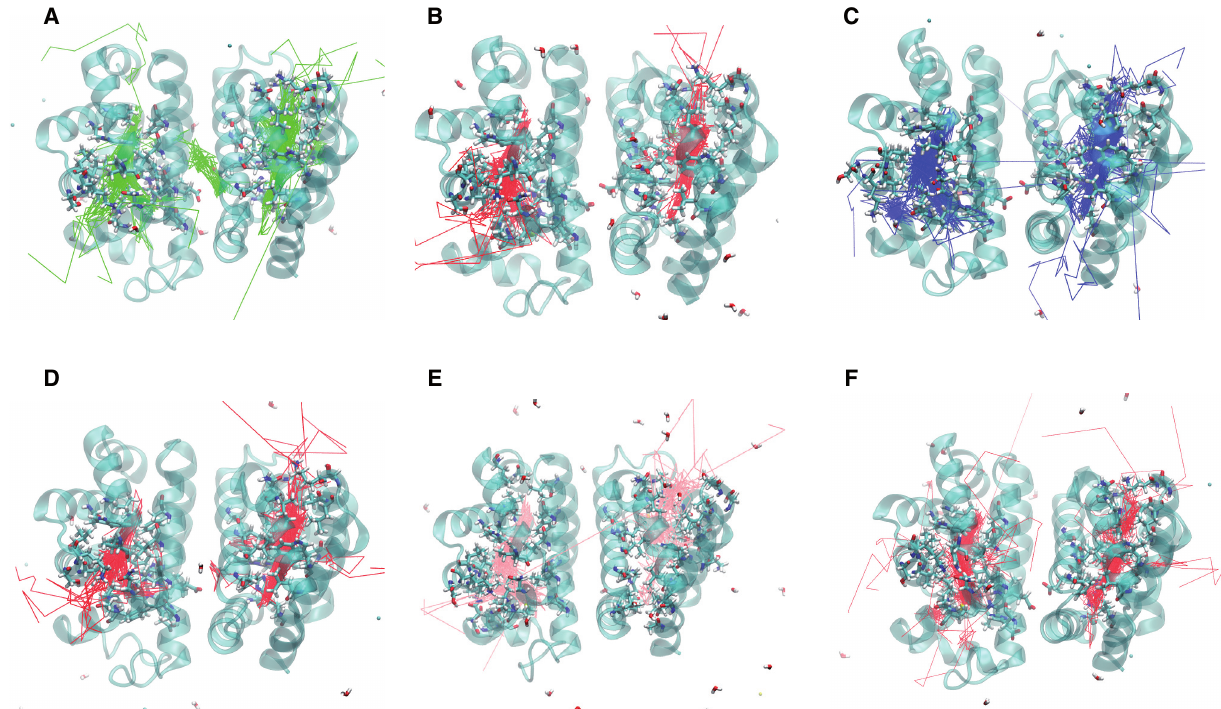
Figure 3. The oxygen trajectories are displayed for all 14 oxygen molecules in the six mutants studied. The trajectory for a particular oxygen molecule was recorded until it escaped the protein, “escape” being defined as more than 5 Å from the protein surface. The trajectories for oxygen molecules that failed to escape were recorded for the entire 10 ns. A. F97L B. F97V C. M37V D. M37F E. I114F F.